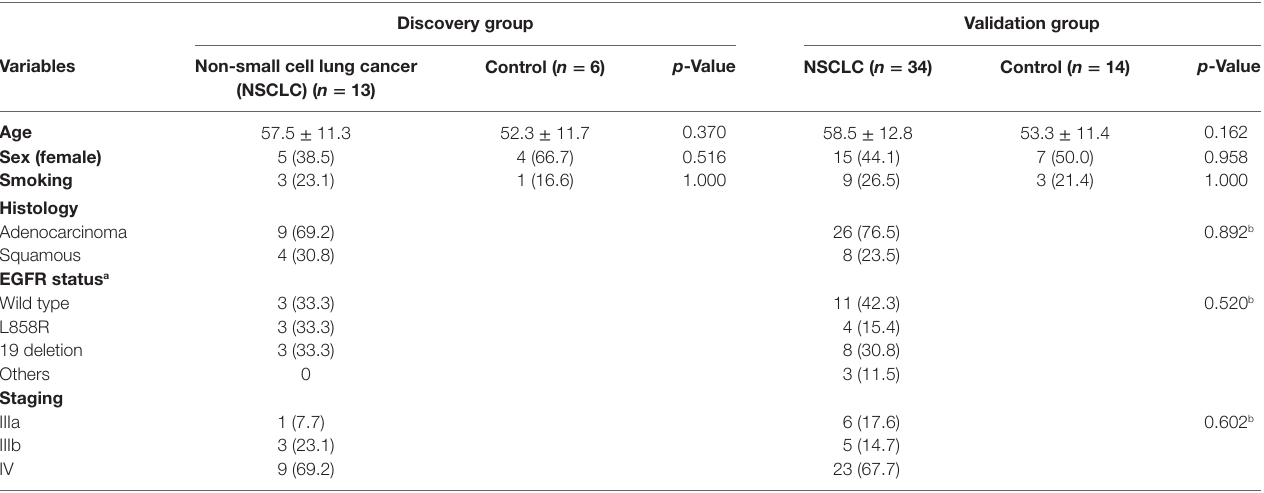
TaBle 1 | Clinical and pathological characteristics of all study subjects.